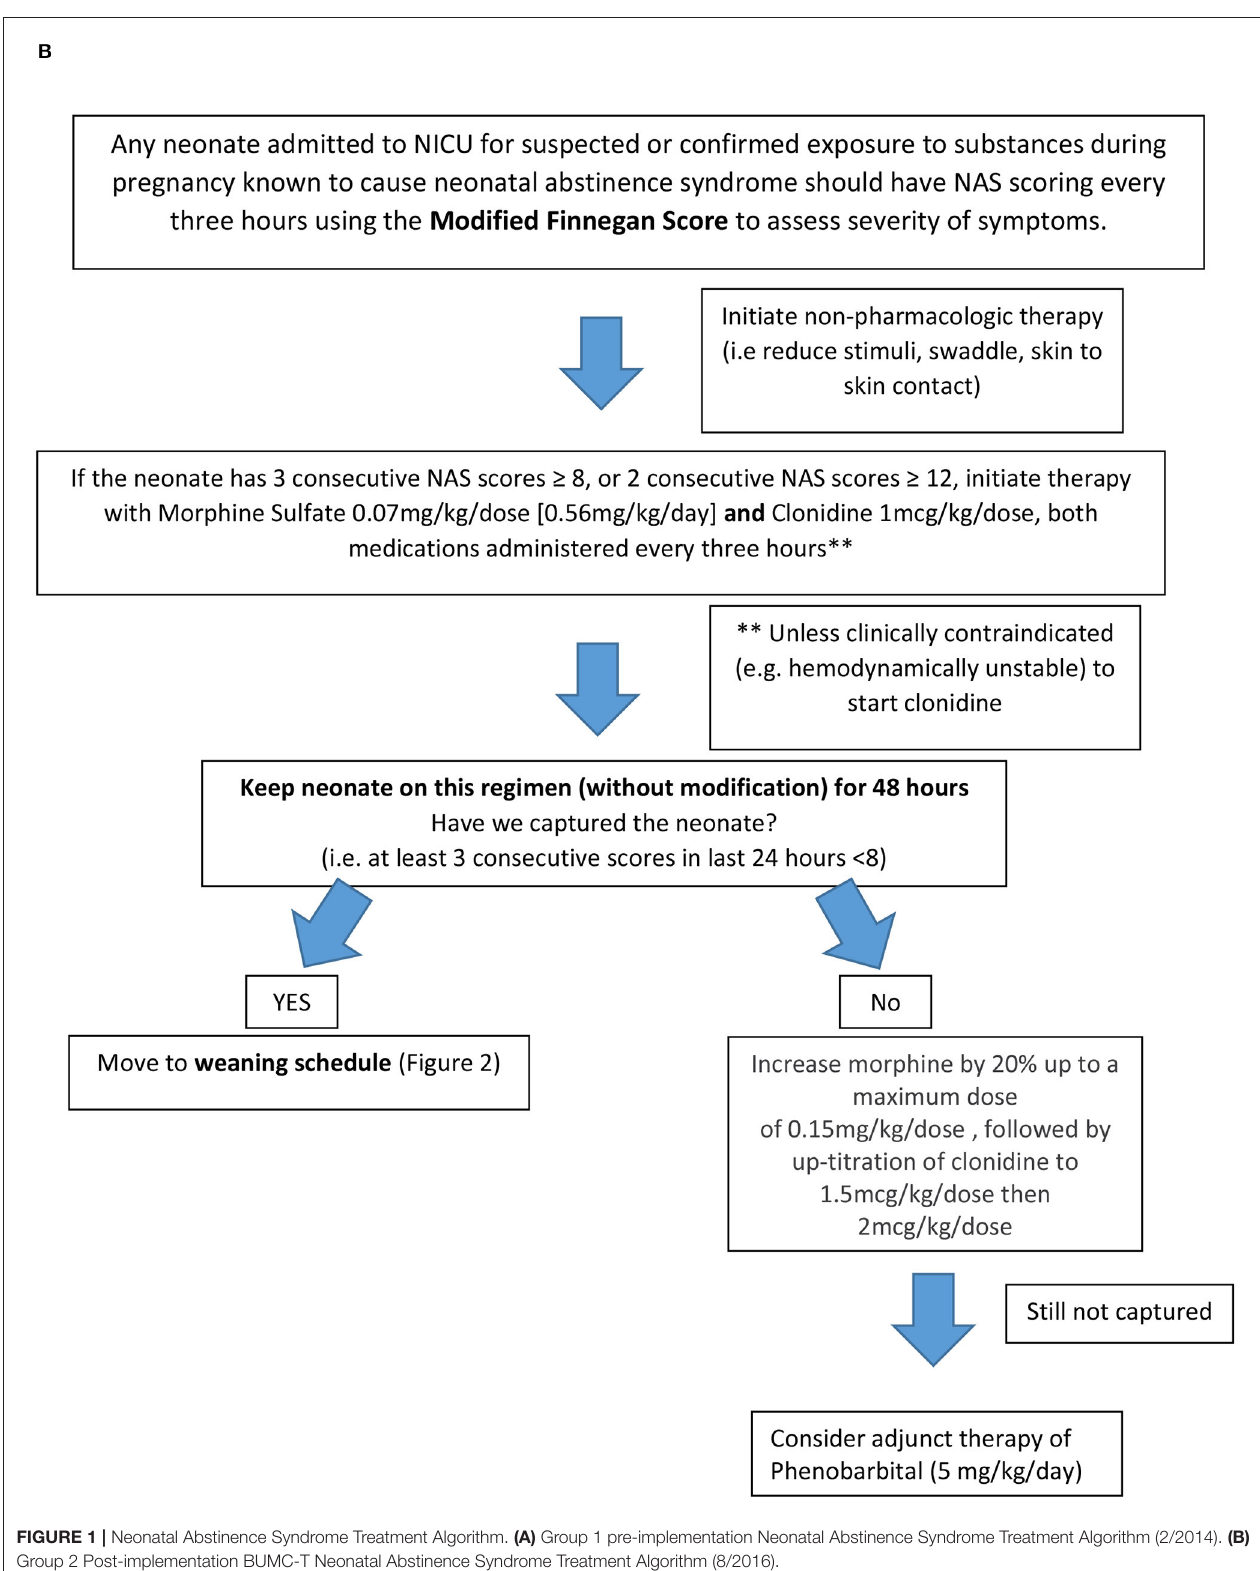
Frontiers in Pediatrics |